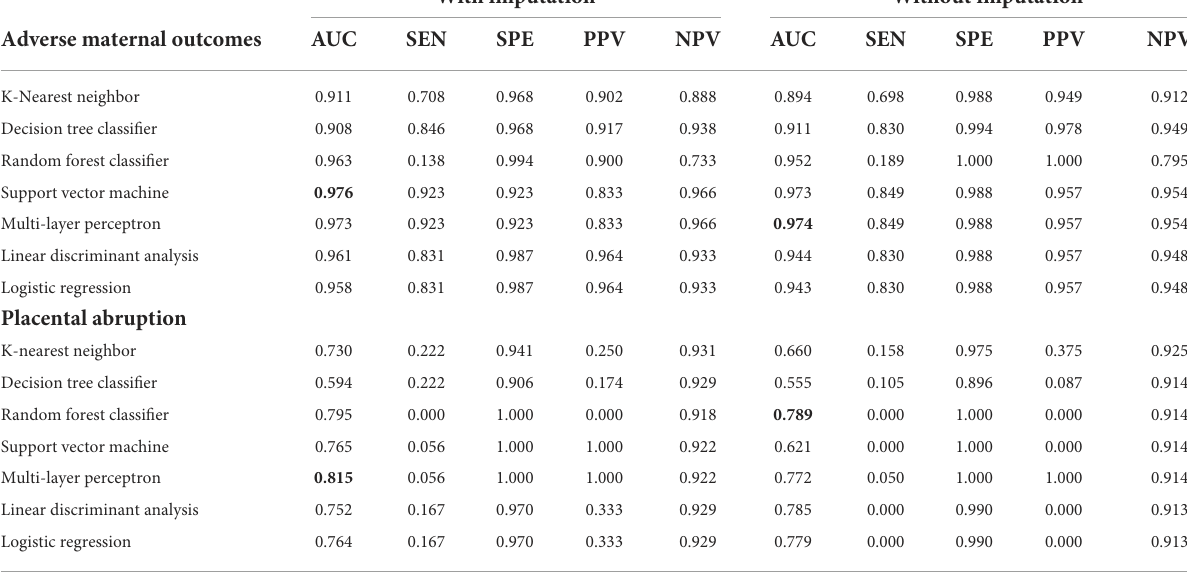
Supplementary Figure 2A, whether the dataset was imputed or not, logistic regression was the recommended model for better probability estimation, as well as RF